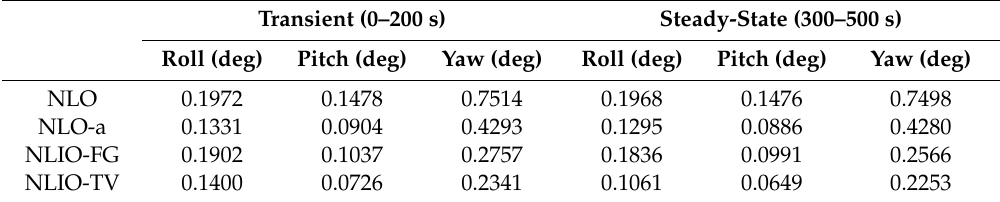
Table 3. MAEs of attitude for all the observers in Case 2.